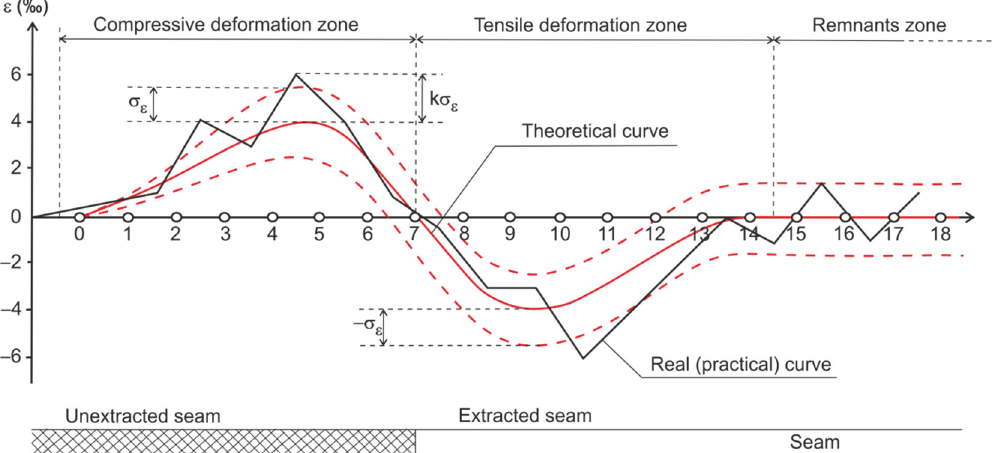
Figure 6. The graph of the theoretical and practical curves of specific horizontal deformations with the area of their standard deviations marked (own study).